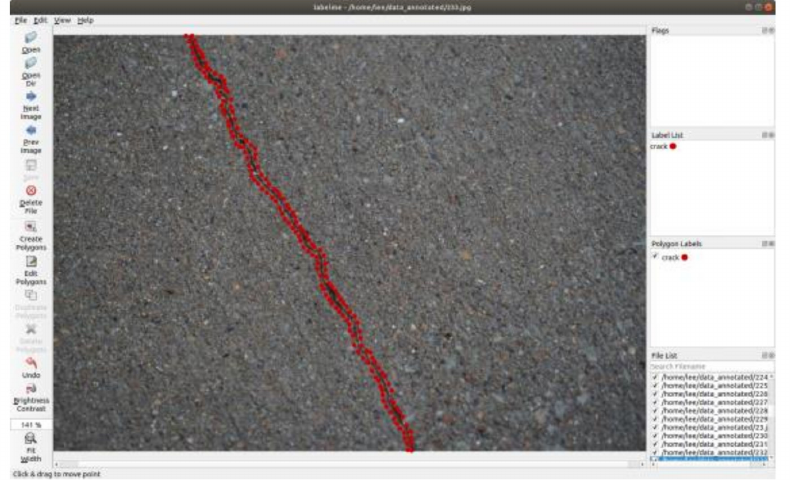
Figure 7. The crack data annotation.